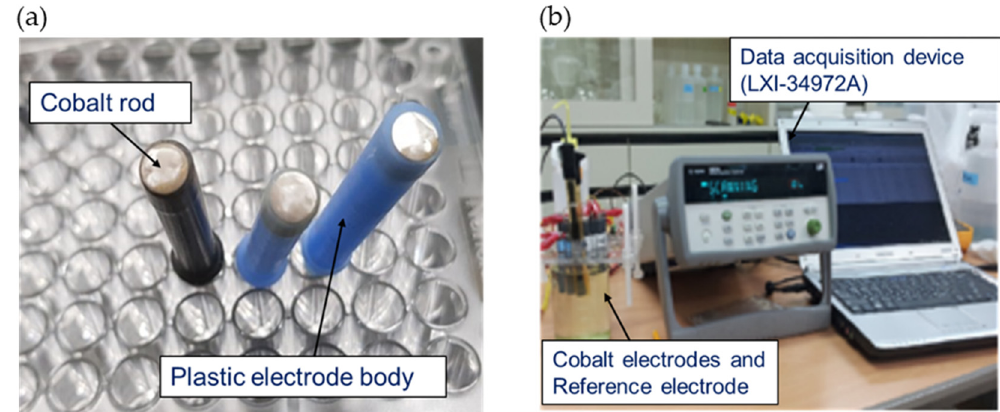
Figure 2. Developed cobalt rod-based electrodes ( a ) and the measurement system of cobalt electrodes used in this study ( b ).